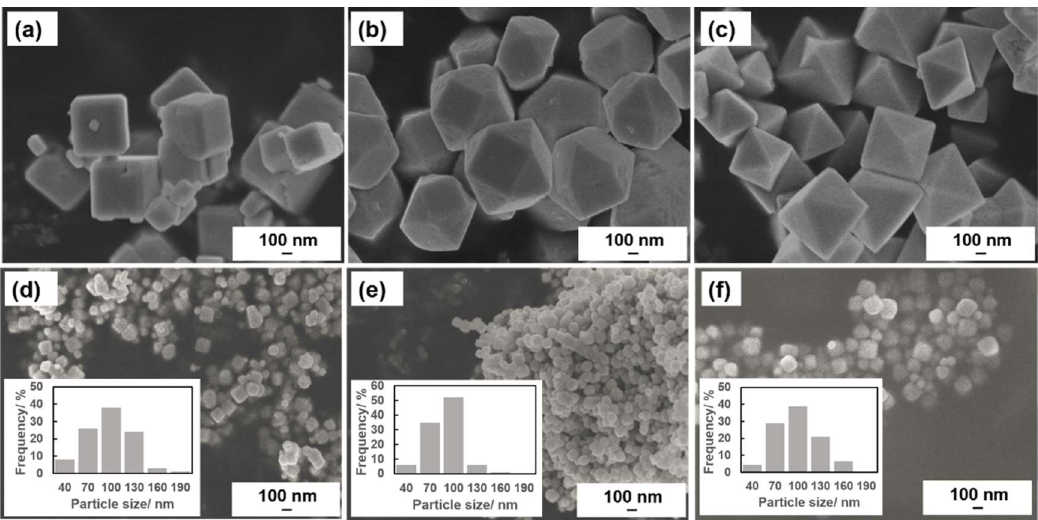
Figure 1. SEM images of faceted Cu 2 O particles (FCPs) synthesized at 328 K ( a–c ) and room temperature ( d–f ). ( a ) cube (c), ( b ) cuboctahedron (co), ( c ) octahedron (o), ( d ) r-c, ( e ) r-co and ( f ) r-o. The size distribution histograms for r-c, r-co and r-o are inserted.